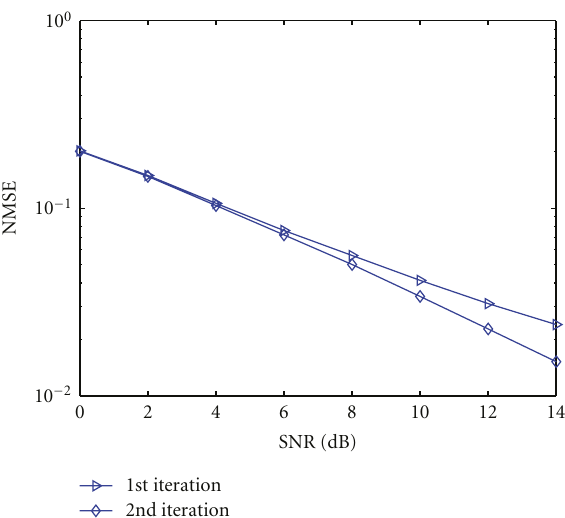
Figure 7: Channel estimation performance of SC systems.